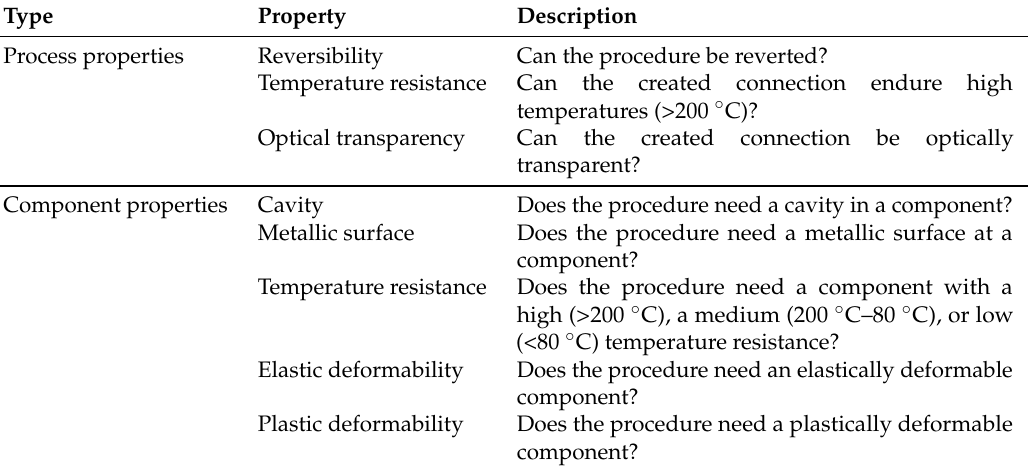
Table 5. Overview of the process and component properties to exclude unsuitable procedure types.